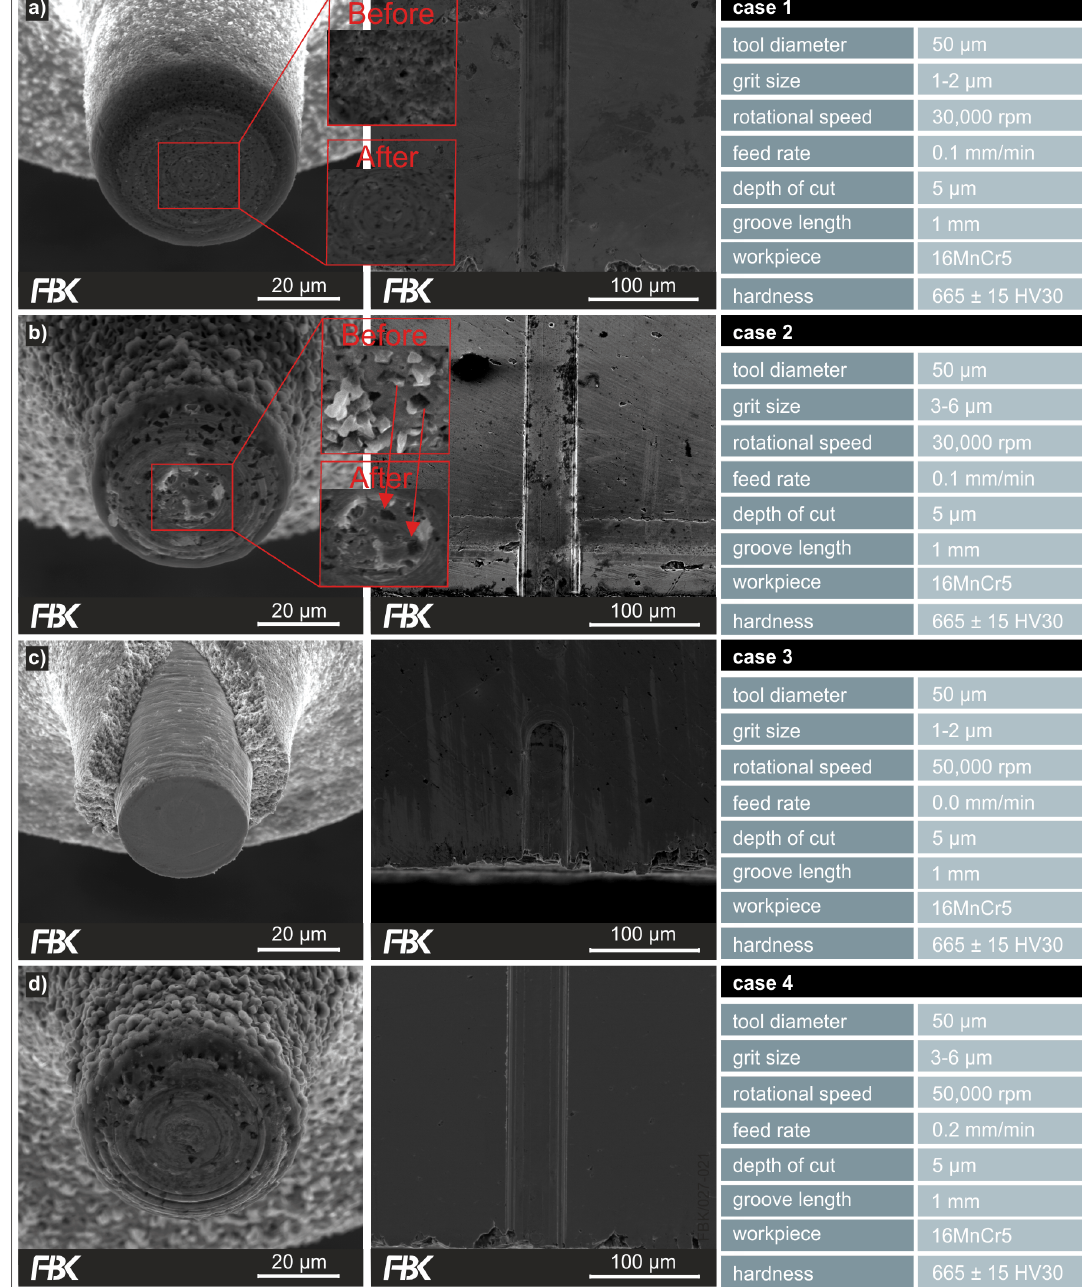
Figure 7. MPGTs after machining ( left column ), entry area of grooves ( middle column ) and process conditions ( right column ), for case 1 ( a ), case 2 ( b ), case 3 ( c ) and case 4 ( d ).